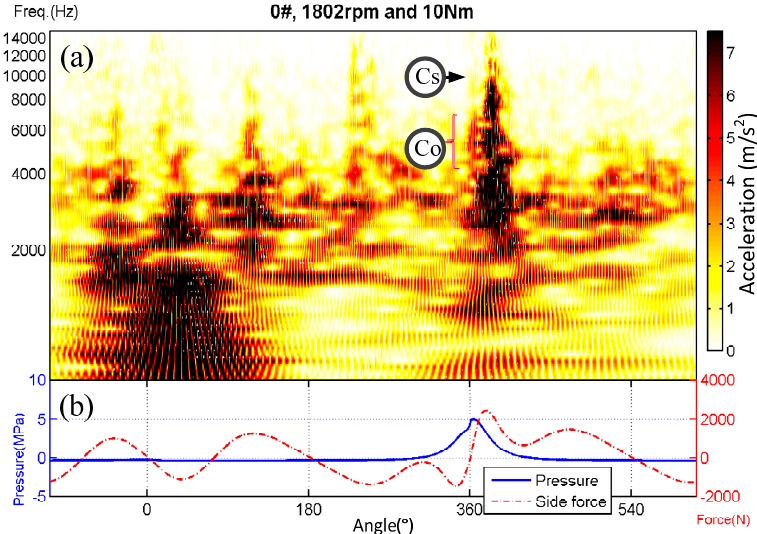
Figure 21. Continuous wavelet transform (CWT) of vibration signal fueled with diesel under 10 Nm and 1800 rpm; ( a ) CWT result of measured acceleration response; ( b ) Measured in-cylinder pressure and calculated piston side-thrust force.